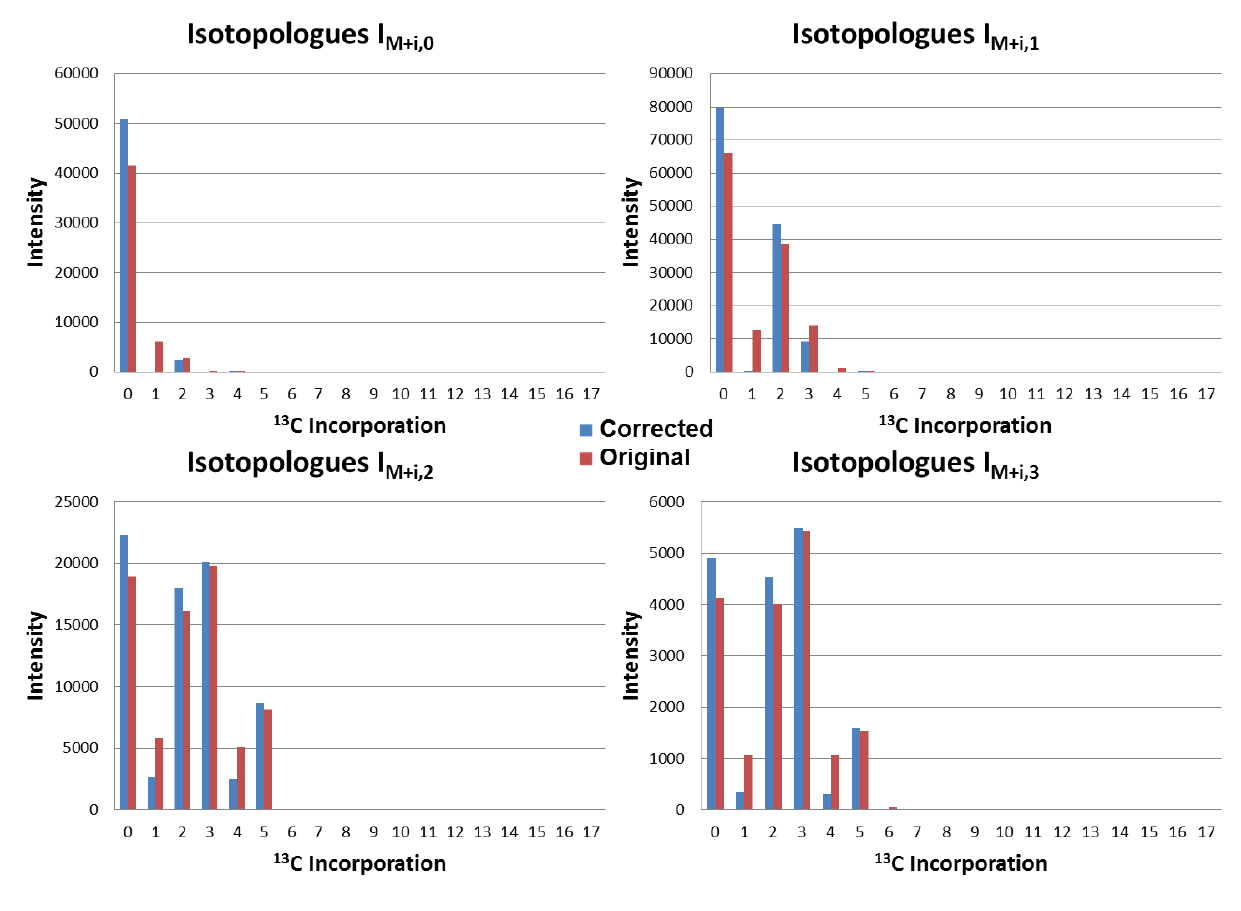
Figure 4. Corrected and observed 13 C/ 15 N isotopologues of UDP-GlcNAc. Each graph represents a set of 13 C-labeled isotopologues with a specific number of 15 N nuclei incorporated. I , I , I , and I represent 0,1,2, and 3 15 N nuclei. Observed intensities are in M+i,0 M+i,1 M+i,2 M+i,3 red and the isotopic natural abundance corrected intensities are in blue. The calculation of the corrected intensities required 12 iterations of the